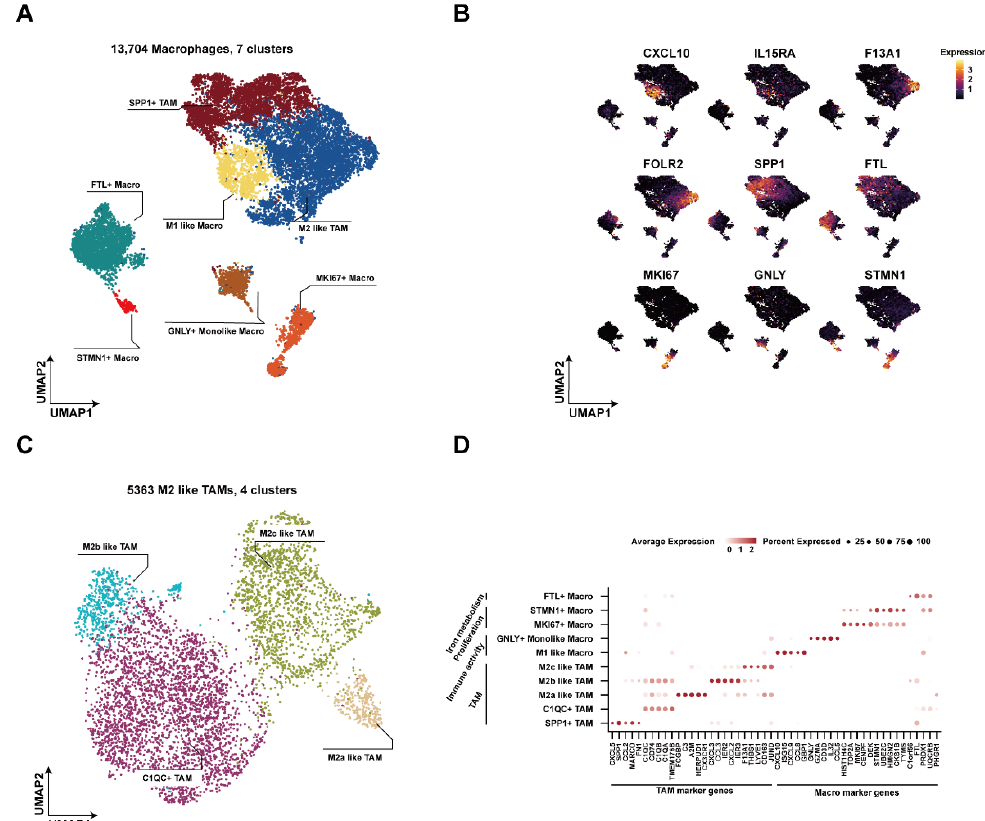
Figure 1. The atlas of macrophages in deficient mismatch repair (dMMR) and proficient mismatch repair (pMMR) tumors: ( A ) a UMAP clustering of macrophages ( n = 13,704) from single-cell RNA sequencing (scRNA-seq) of CRC patients shows seven clusters; ( B ) expression of marker genes in seven clusters of macrophages; ( C ) a UMAP clustering of M2-like tumor-associated macrophages (TAMs) ( n = 5363) showing four clusters; ( D ) the dot plot shows the expression of the top five marker genes in all subpopulations of macrophages.